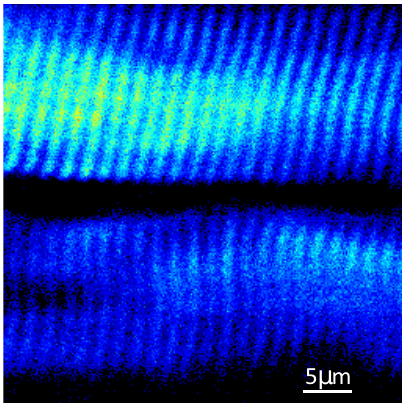
Fig. 8. SHG image of muscle ¯bers in the mouse medial thigh muscle acquired with the DIVER's trans-detector.